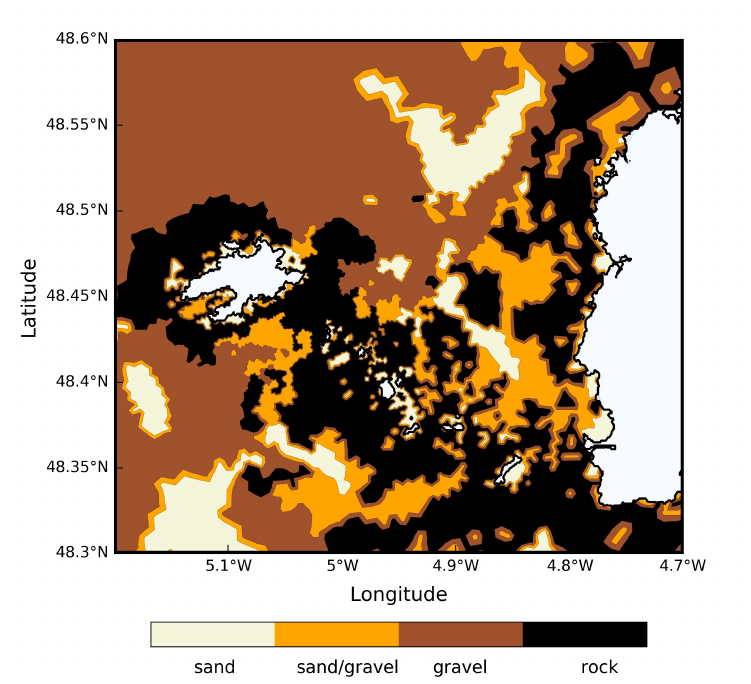
Figure 3. Sediment bottom types in and around the Fromveur Strait (adapted from